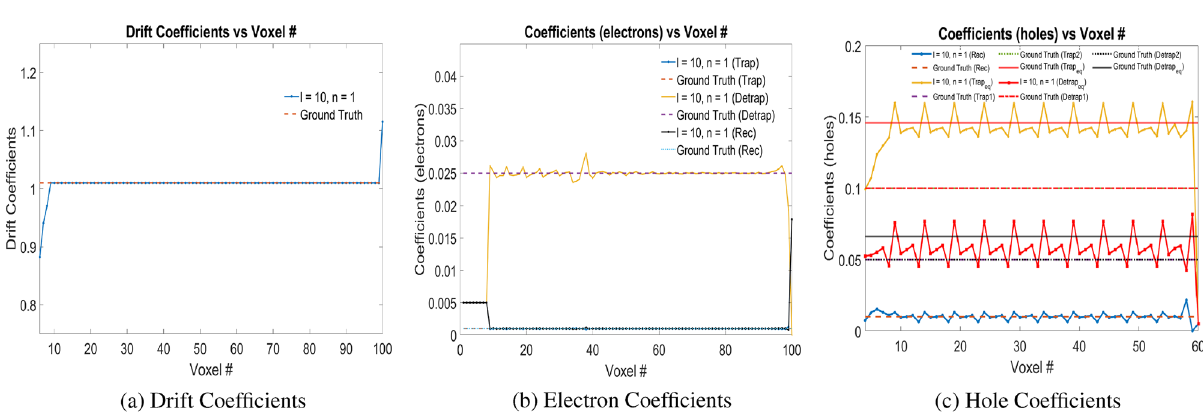
Figure 7. ( a ) Drift coefficients ( µ e ), ( b ) electron coefficients ( w eT ,1 , w eD ,1 , w eRec ), and, ( c ) hole coefficients ( w hT ,1 , w hT ,2 , w hT , eq , w hD ,1 , , w hD ,2 , w hD , eq , w hRec ) for e–h injection at voxel positions 9 with stride of 5 voxels until voxel 59 for l and n in Physical Model-3 as shown in the plot legend. Rec in the legend refers to recombination coefficients. Readers are suggested to enlarge the figure for closer